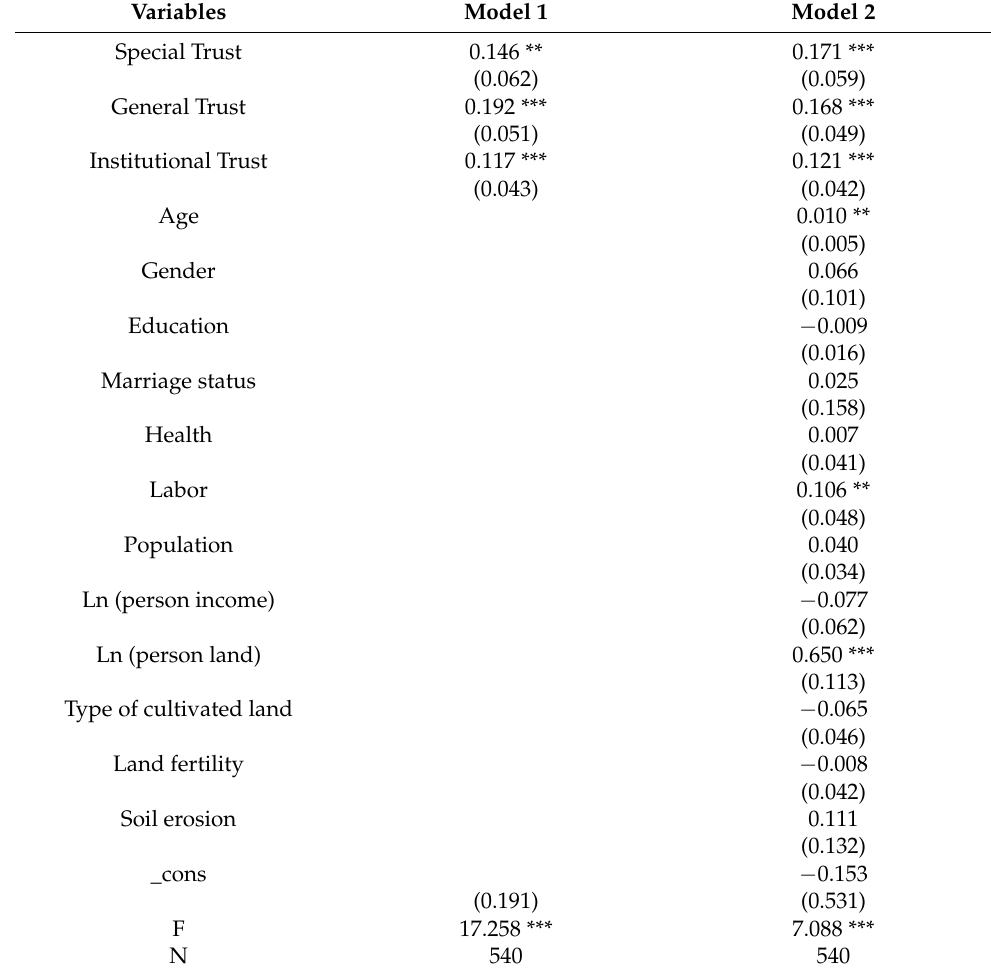
Table 2. The regression results of farmers’ trust in